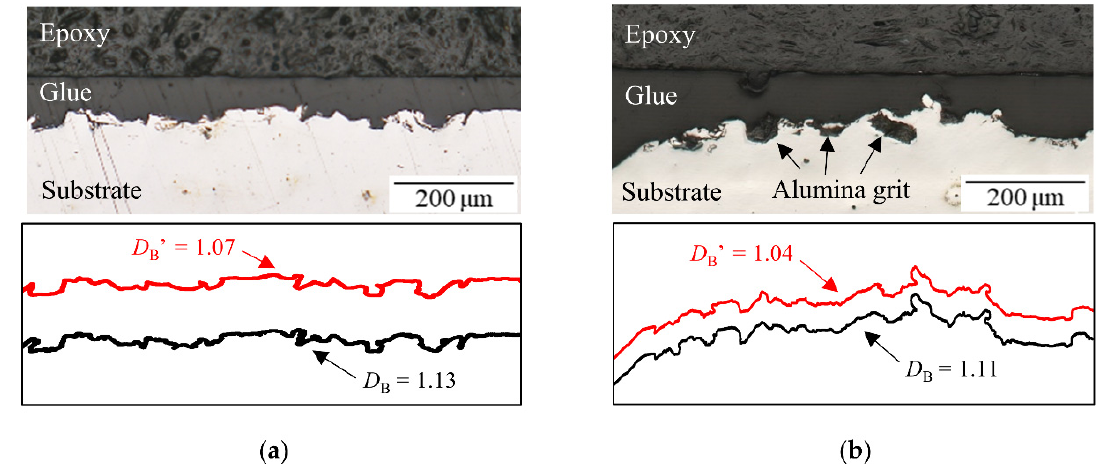
Figure 8. Fractal dimension ( D B ) analysis shows the mechanical interlock at the interface between the glue and the blasted substrate: ( a ) MST, ( b ) MAL.